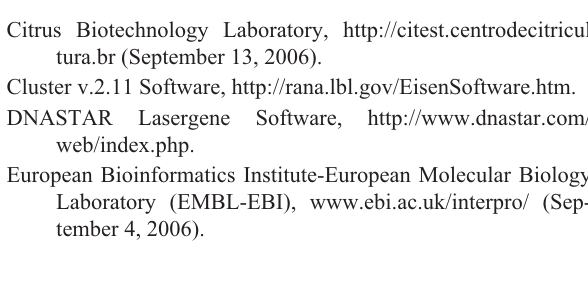
Table S10 - Citrus ESTs with homology to alternative oxidase protein families from Arabidopsis thaliana . Table S11 - Citrus ESTs with homology to catalase protein families from Arabidopsis thaliana